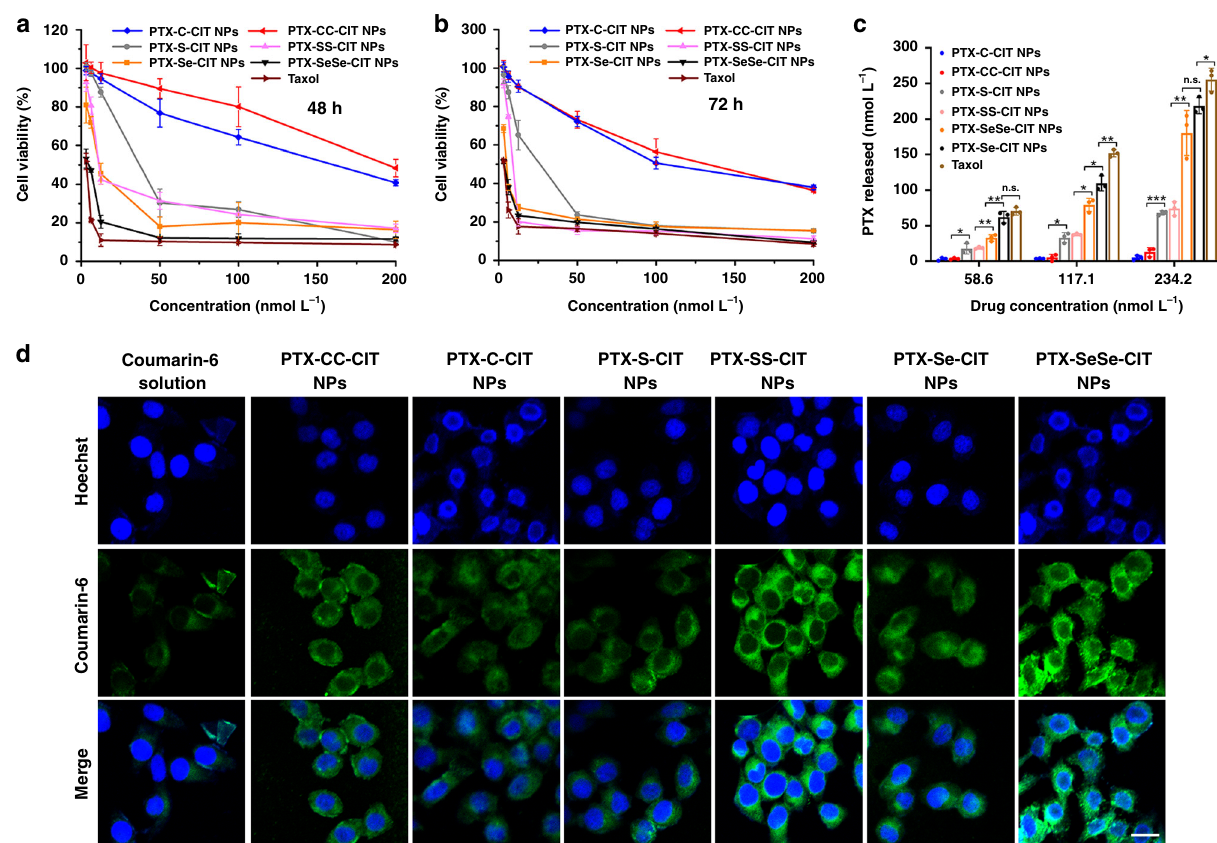
Fig. 3 Cytotoxicity assay and cellular uptake. Viability of KB cells after treated with various concentrations of Taxol and prodrug nanoassemblies for ( a ) 48 h and ( b ) 72 h. Data are presented as mean ± SD (three independent experiments). ( c ) Free PTX released from prodrug nanoassemblies after incubation with KB cells for 48 h. Data are presented as mean ± SD (three independent experiments). * P < 0.05, ** P < 0.01, *** P < 0.001 by